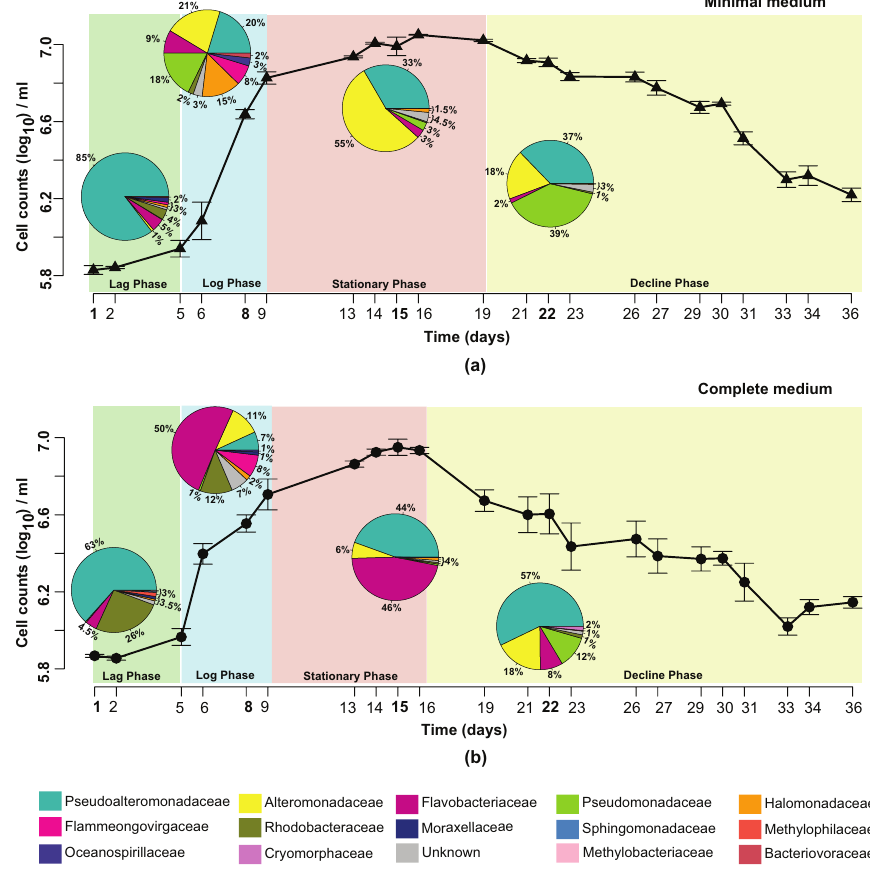
Figure 2. Bacterial community profile of P. tricornutum (CCAP 1052/1B) over a 36 day period in culture conditions: ( a ) minimal media; ( b ) complete media. The growth curves are partitioned into lag (green), log (blue), stationary (red), and decline (yellow) phases. The abundance (%) of the “Top Ten” bacterial families (corresponding colors described in the key) is depicted in pie charts on days 1, 8, 15 and 22 in both media